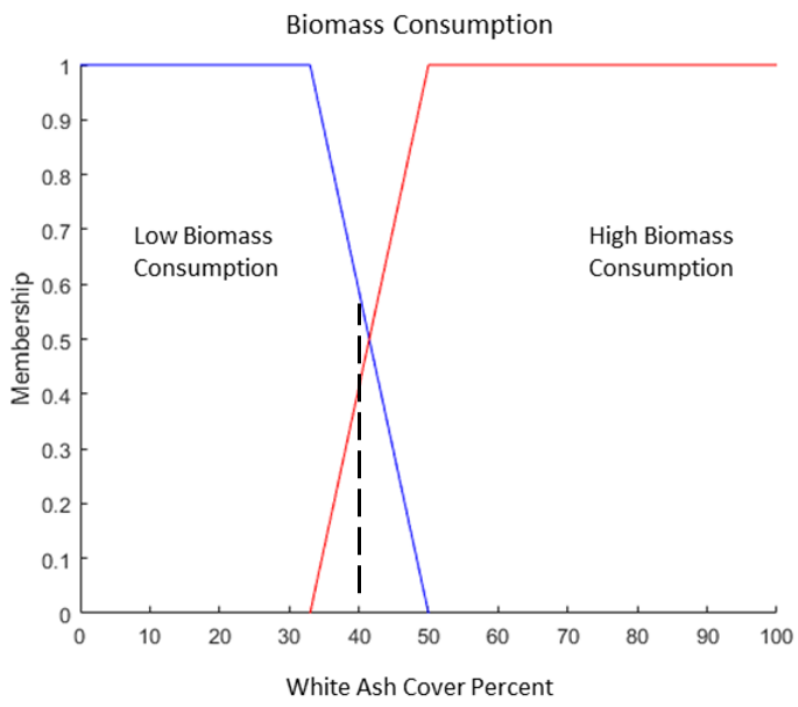
Figure 11. Biomass Consumption Fuzzy Set Membership. With 40 percent White Ash Cover denoted by the dotted line, there is 0.41 membership in High Biomass Consumption and 0.59 membership in Low Biomass Consumption.